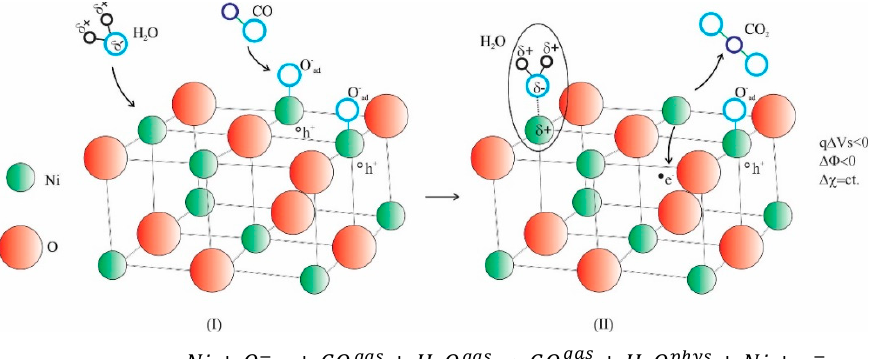
Figure 9. Cartoon revealing the interaction between CO and pre-adsorbed oxygen for NiO-sensitive surface under RH background.